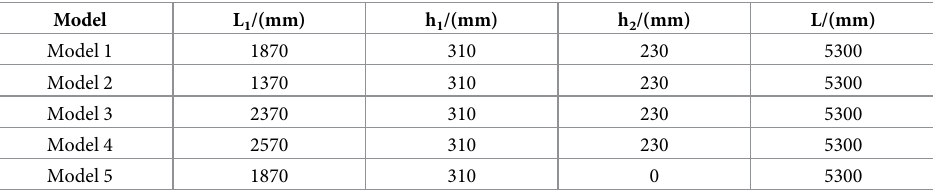
Table 3. Geometric parameters of different models.